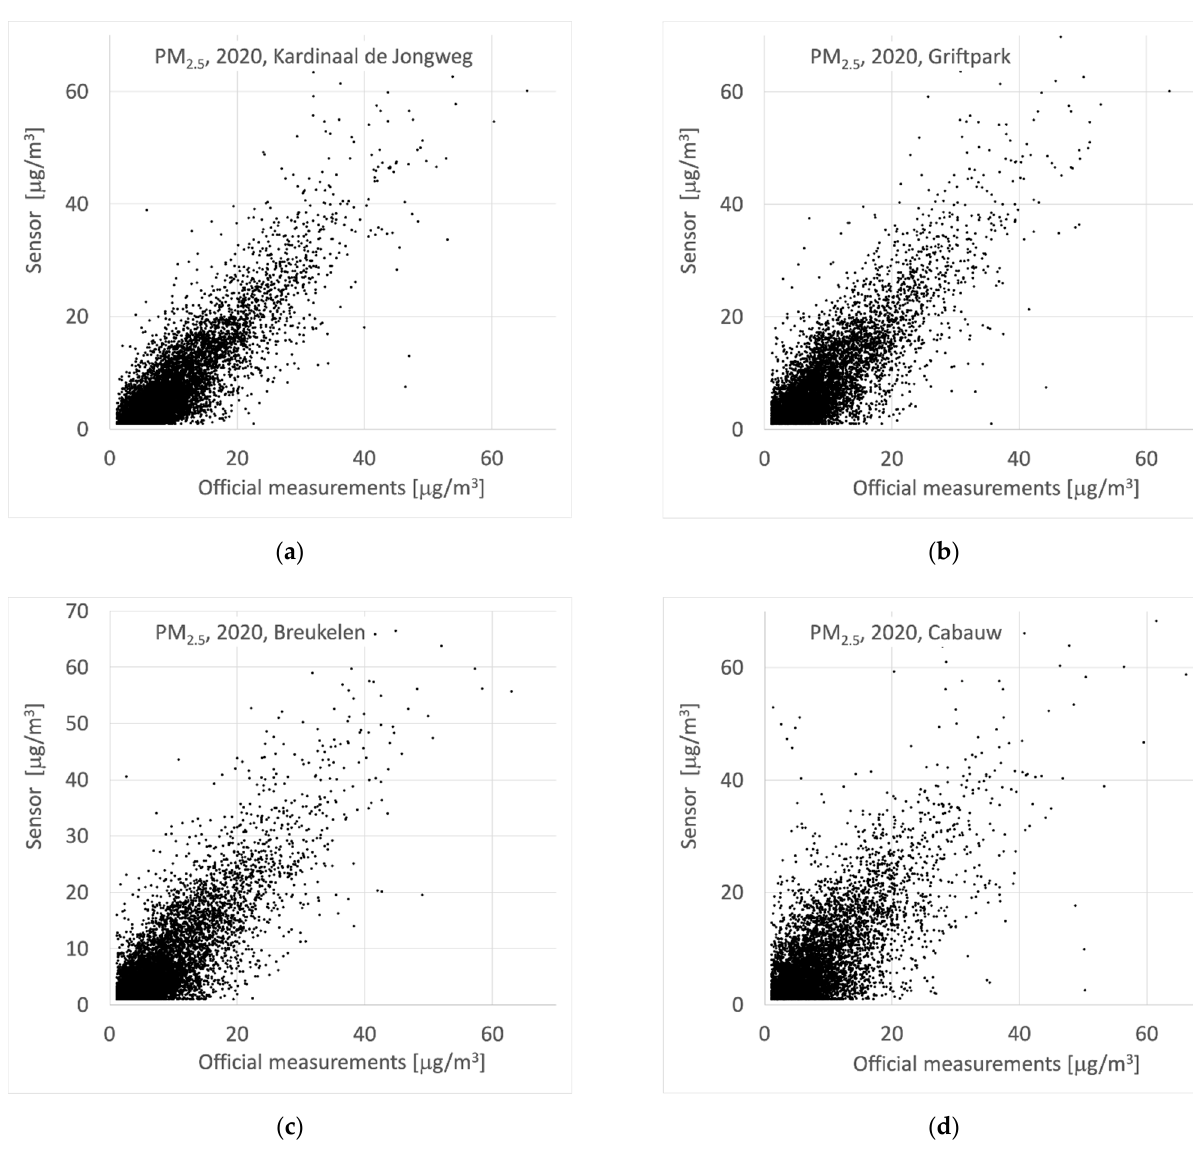
Figure 5. ( a ) Results of official measurements and nearby/co-located sensors at Kardinaal de Jongweg; ( b ) results of official measurements and nearby sensor at Griftpark; ( c ) results of official measurements and nearby/co-located sensors at Breukelen; ( d ) results of official measurements and nearby/co-located sensors at Cabauw.